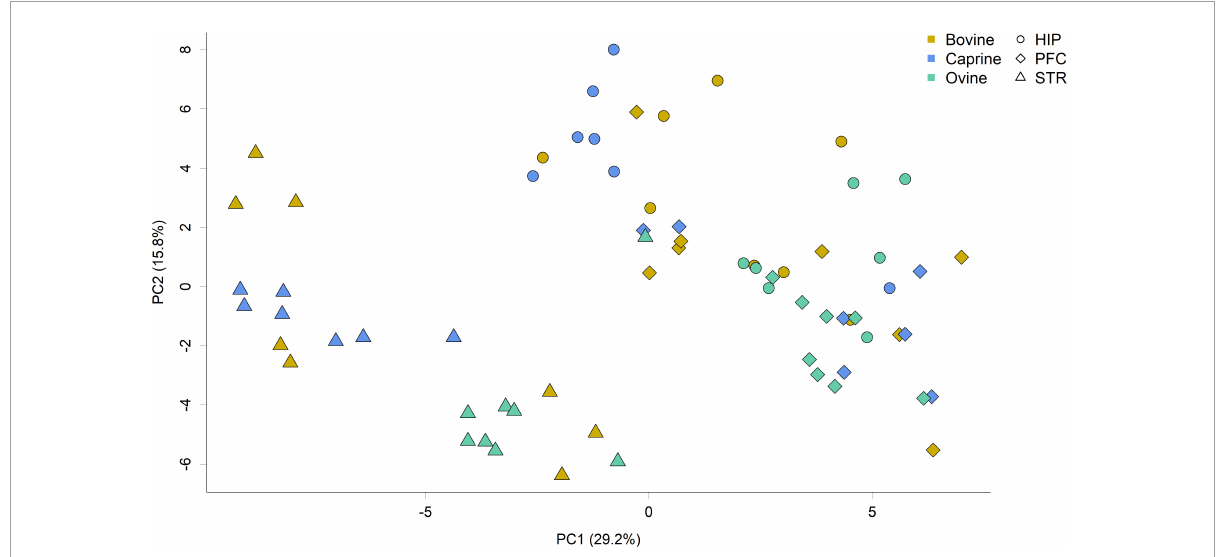
FIGURE1 Principal component analysis score plot showing gene expression profiles of tissue samples from the hippocampus, striatum and prefrontal cortex of pigs fed milk from bovine, caprine, or ovine species. The first two principal components are plotted. Colors indicate milk treatments, and shape indicates different brain regions. Percentages of variation explained by each principal component are indicated along the axes. HIP, hippocampus; PFC, prefrontal cortex; STR, striatum; PC, principal